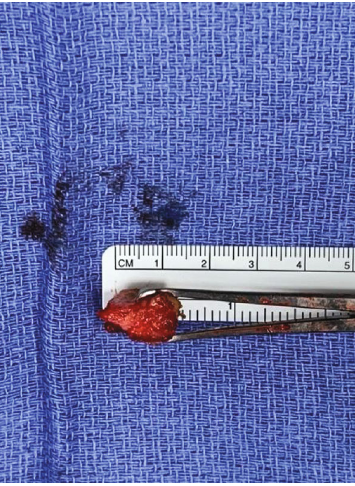
Figure 6: Fabella sizing ( 1 : 5 cm × 1cm × 1 cm